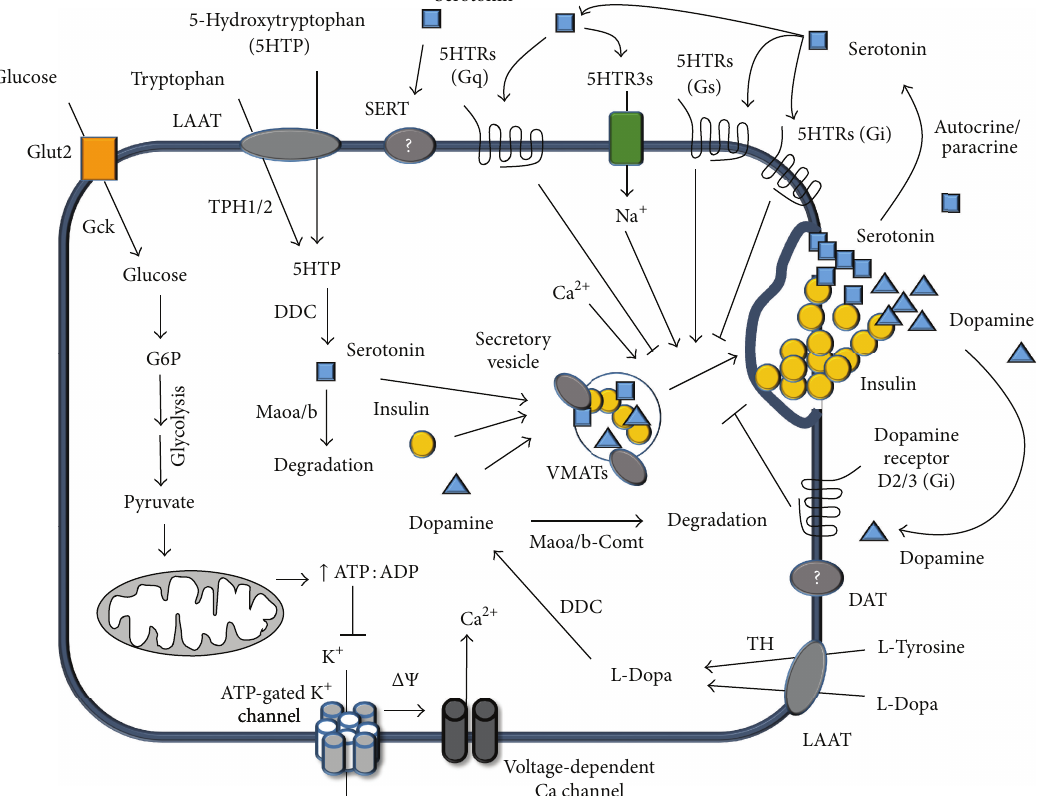
Figure 6: Outline of serotoninergic and dopaminergic systems in 𝛽 -cells and its role in insulin secretion. Glucose enters into pancreatic 𝛽 -cell via the insulin independent glucose transporter (Glut2 in mice), allowing its metabolism through glycolysis, Krebs cycle, and oxidative phosphorylation. The increase in the ATP/ADP ratio induces the inhibition of the ATP dependent potassium channel and consequently the plasma membrane depolarization, triggering the extracellular calcium uptake and the insulin granules exocytosis. Both serotonin precursors, 5HTP and L-tryptophan, and the dopamine precursors, L-tyrosine and L-Dopa, can enter into the 𝛽 -cell by the LAAT transporter. The first two precursors may be converted to serotonin by action of the enzymes TPH1/2 and DDC, while the latter precursors could be converted to dopamine by the enzymes TH and DDC. These newly synthesized monoamines are stored in the secretory granules by the vesicular carriers (VMAT1/2).Inresponsetoglucosestimuli,the 𝛽 -cellscanreleaseinsulin,togetherwithserotoninanddopamine.Therefore,bothextracellular monoamines can exert their actions on insulin secretion depending on which specific receptors are activated. Serotonin and dopamine may inhibit the glucose-stimulated insulin secretion acting by Htr2c and D3 receptors, respectively. We propose that the exposure of pancreatic 𝛽 -cells to the nonesterified fatty acids, palmitic and oleic acids, may lead to a decreased expression of Maob and thus an accumulation of the monoamines, serotonin and dopamine. When these monoamines are released, they signal through their specific receptors, which may contribute to a decreased glucose-stimulated insulin